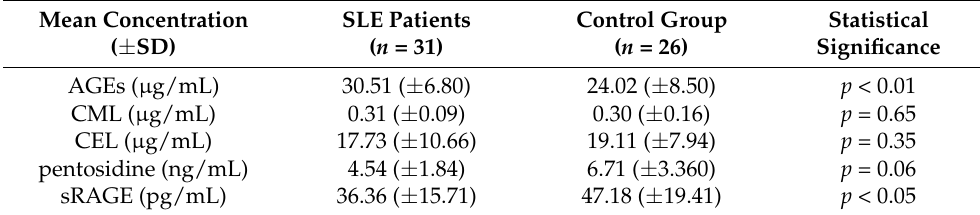
Table 2. Results of the ELISA assay and their statistical significance. Mean